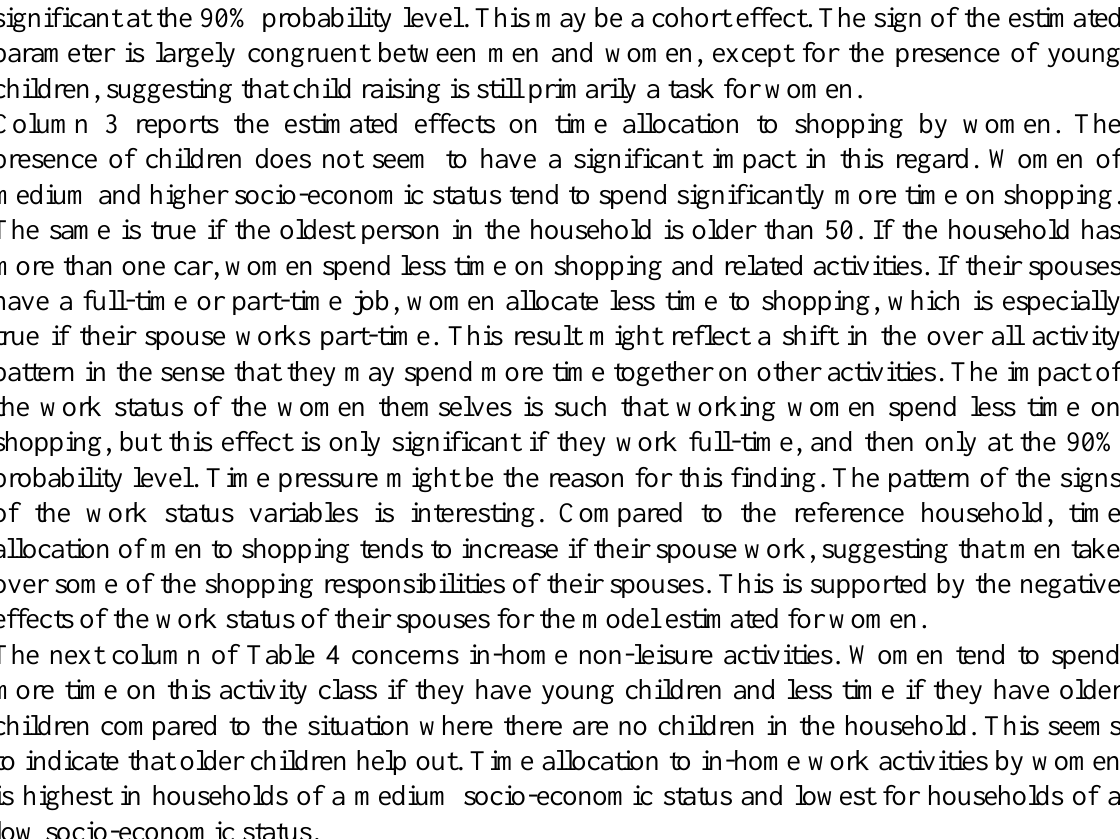
Table 4. Effects of the independent variables on the time allocation of women Variable Care Work